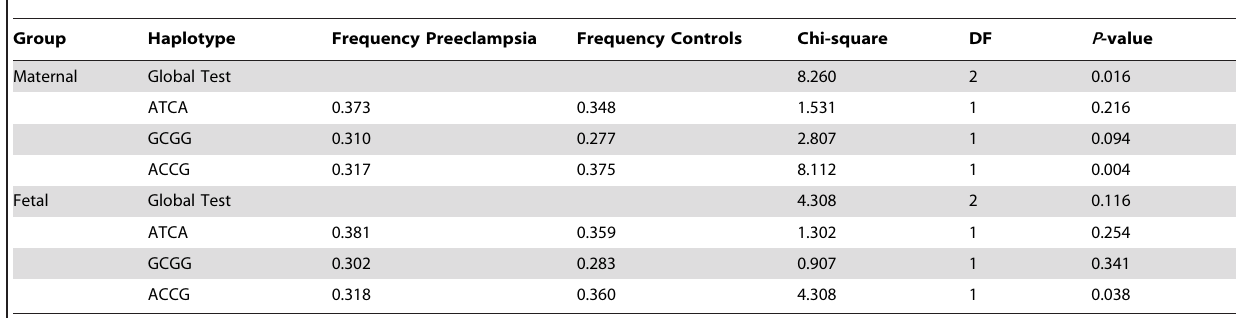
Table 2. COMT haplotype analysis for mothers and fetuses with and without preeclampsia.